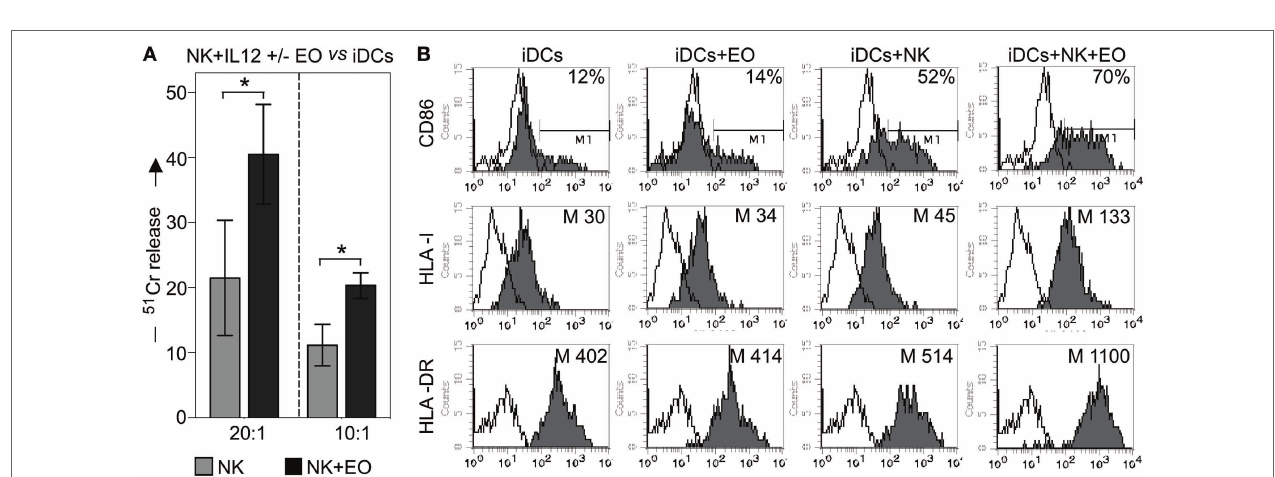
FigUre 5 | nK cells exposed to eosinophils (eOs) display a higher capability to kill myeloid immature Dcs (iDcs) and to induce their maturation . (a) IL12-conditioned NK cells were cultured o.n. with EOs at an E : T ratio of 1:1, then harvested and analyzed for cytolytic activity against iDCs at various E / T ratios. Gray bars refer to lysis by NK cells cultured alone, black bars represent lysis by NK cells cocultured with EOs. The average of six independent experiments is shown (% ± SD). * P < 0.05. (B) IL12-conditioned NK cells were cultured o.n. with EOs at an E : T ratio of 1:1; the same NK cells were then cocultured with iDCs. After o.n., dendritic cells (DCs) were harvested and assessed by flow cytometric analysis for maturation markers such as CD86, HLA-I, and HLA-DR. For comparison, iDCs were cultured either alone or with EOs and NK cells separately. These analyzes were performed by gating on CD1a + /ToPro3 − cells. Open profiles indicate staining with PE-conjugated anti-mouse IgG secondary reagent. The percentage of CD86 and the median value of HLA-I and HLA-DR on DCs are shown for a representative donor out of six